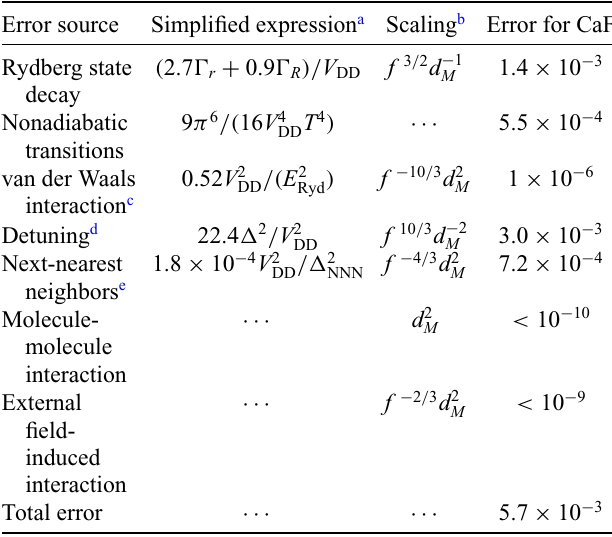
TABLE I. Gate error and scaling with molecule properties. Error